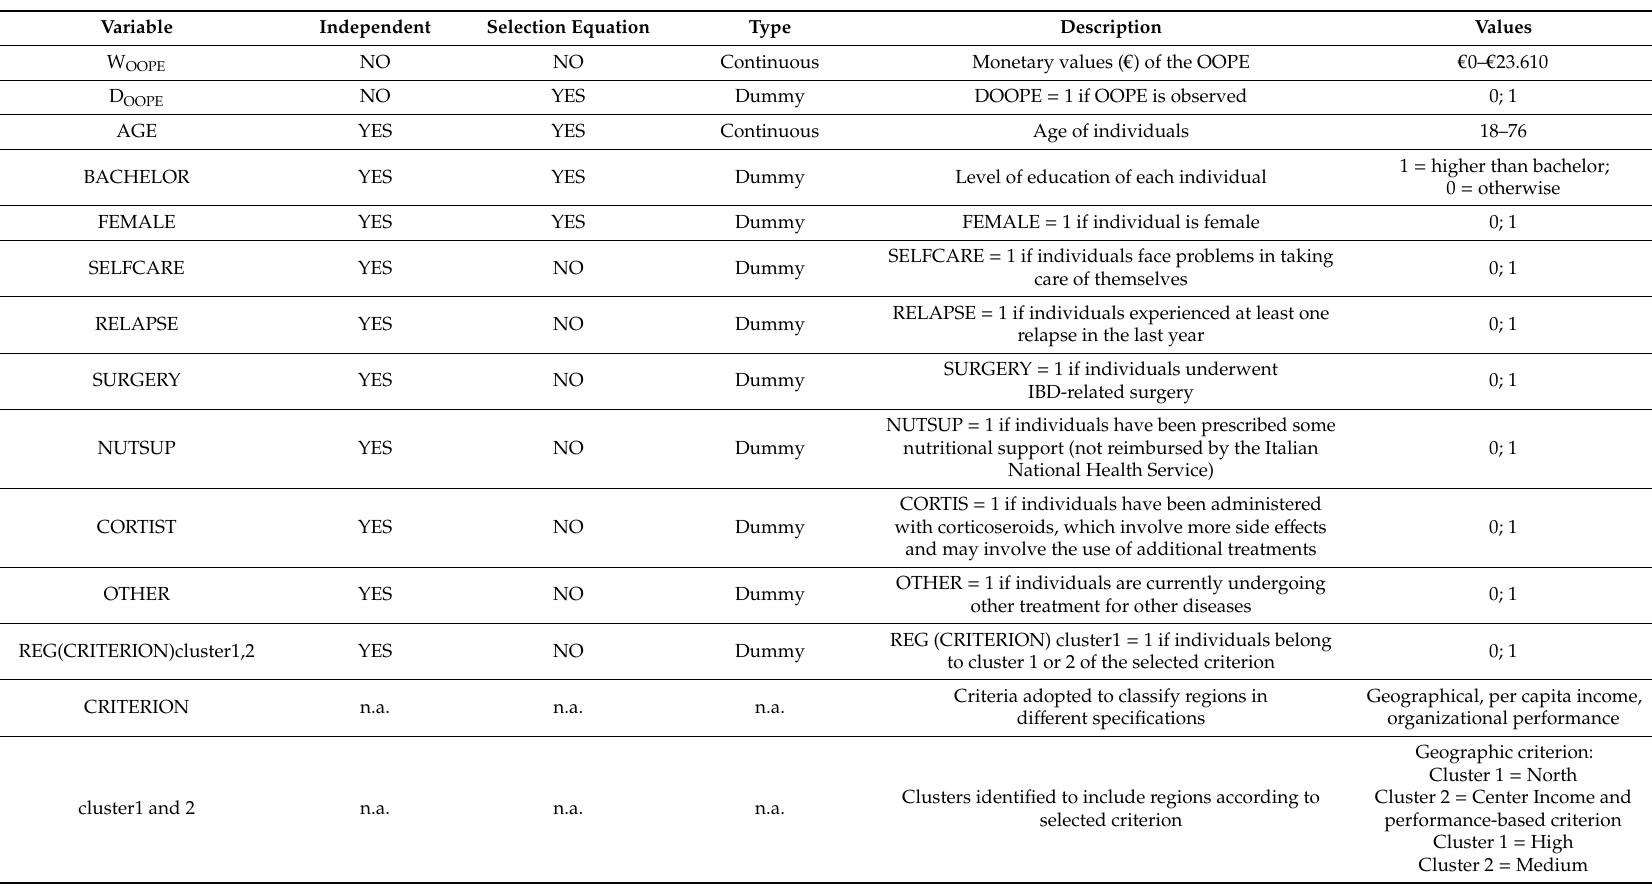
Table 2. Variables included in the model. OOPE: Out-of-Pocket Expendture; IBD: Inflammatory Bowel